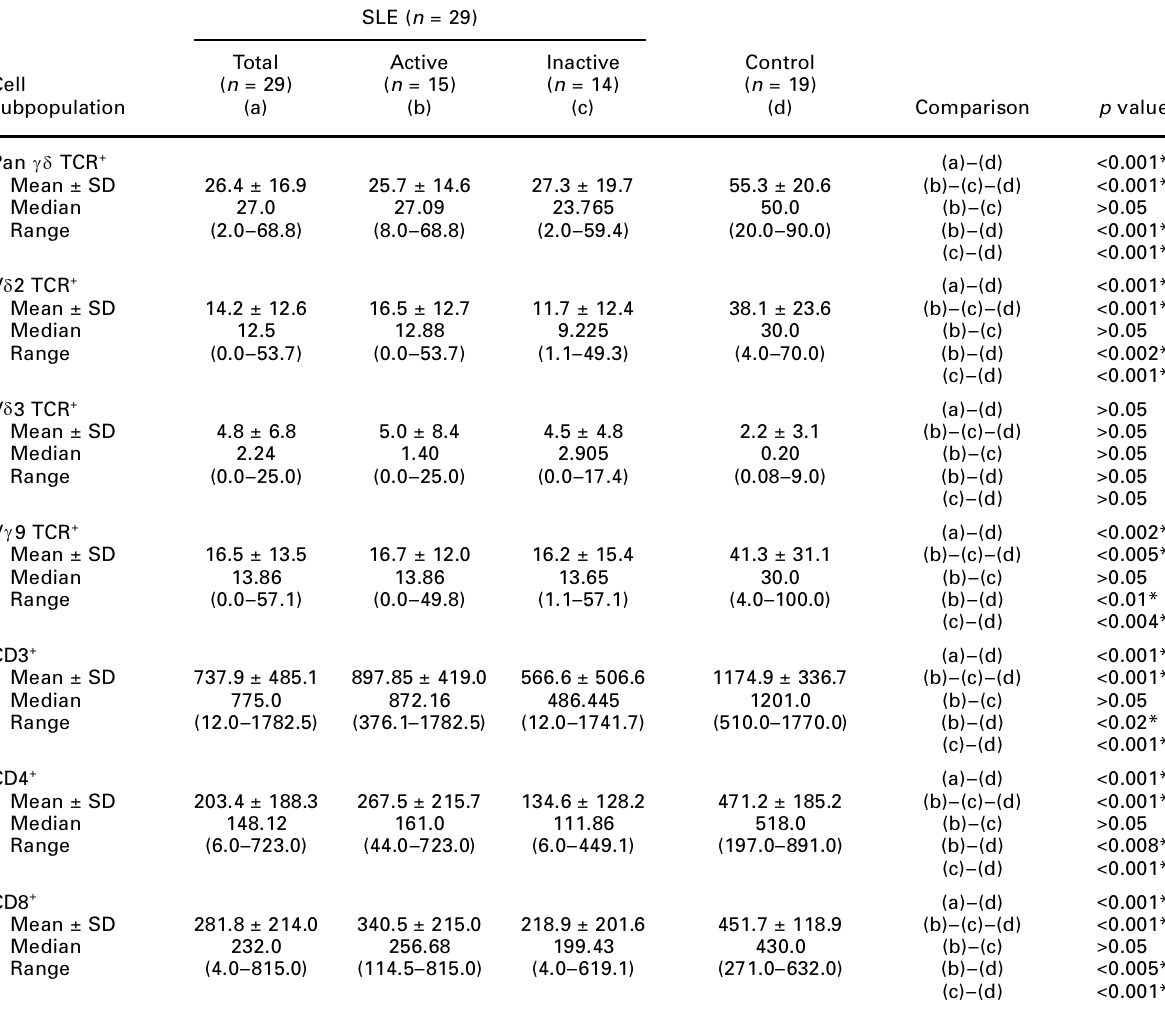
Table 2. Analysis of g d TCR expression on peripheral blood T cells in patients with SLE and healthy donors (cell donors/ m l)